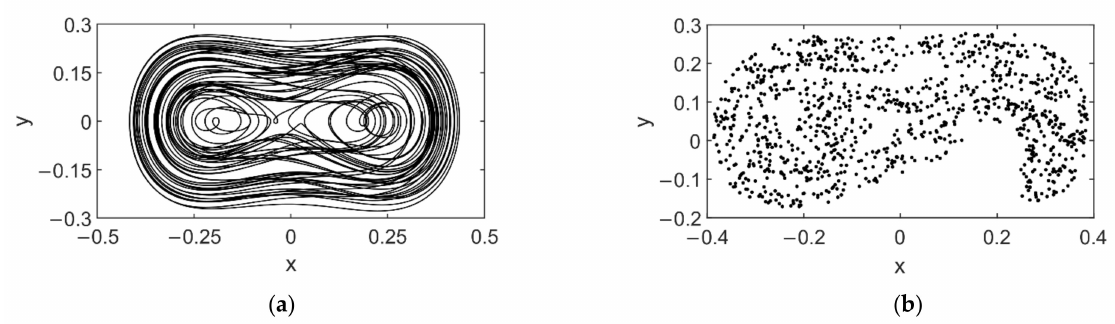
Figure 5. Dynamic behavior of the system (5) for V AC = 0.16 V, V b = 3.8 V, ω = 0.5: ( a ) phase portrait; ( b ) Poinc á re